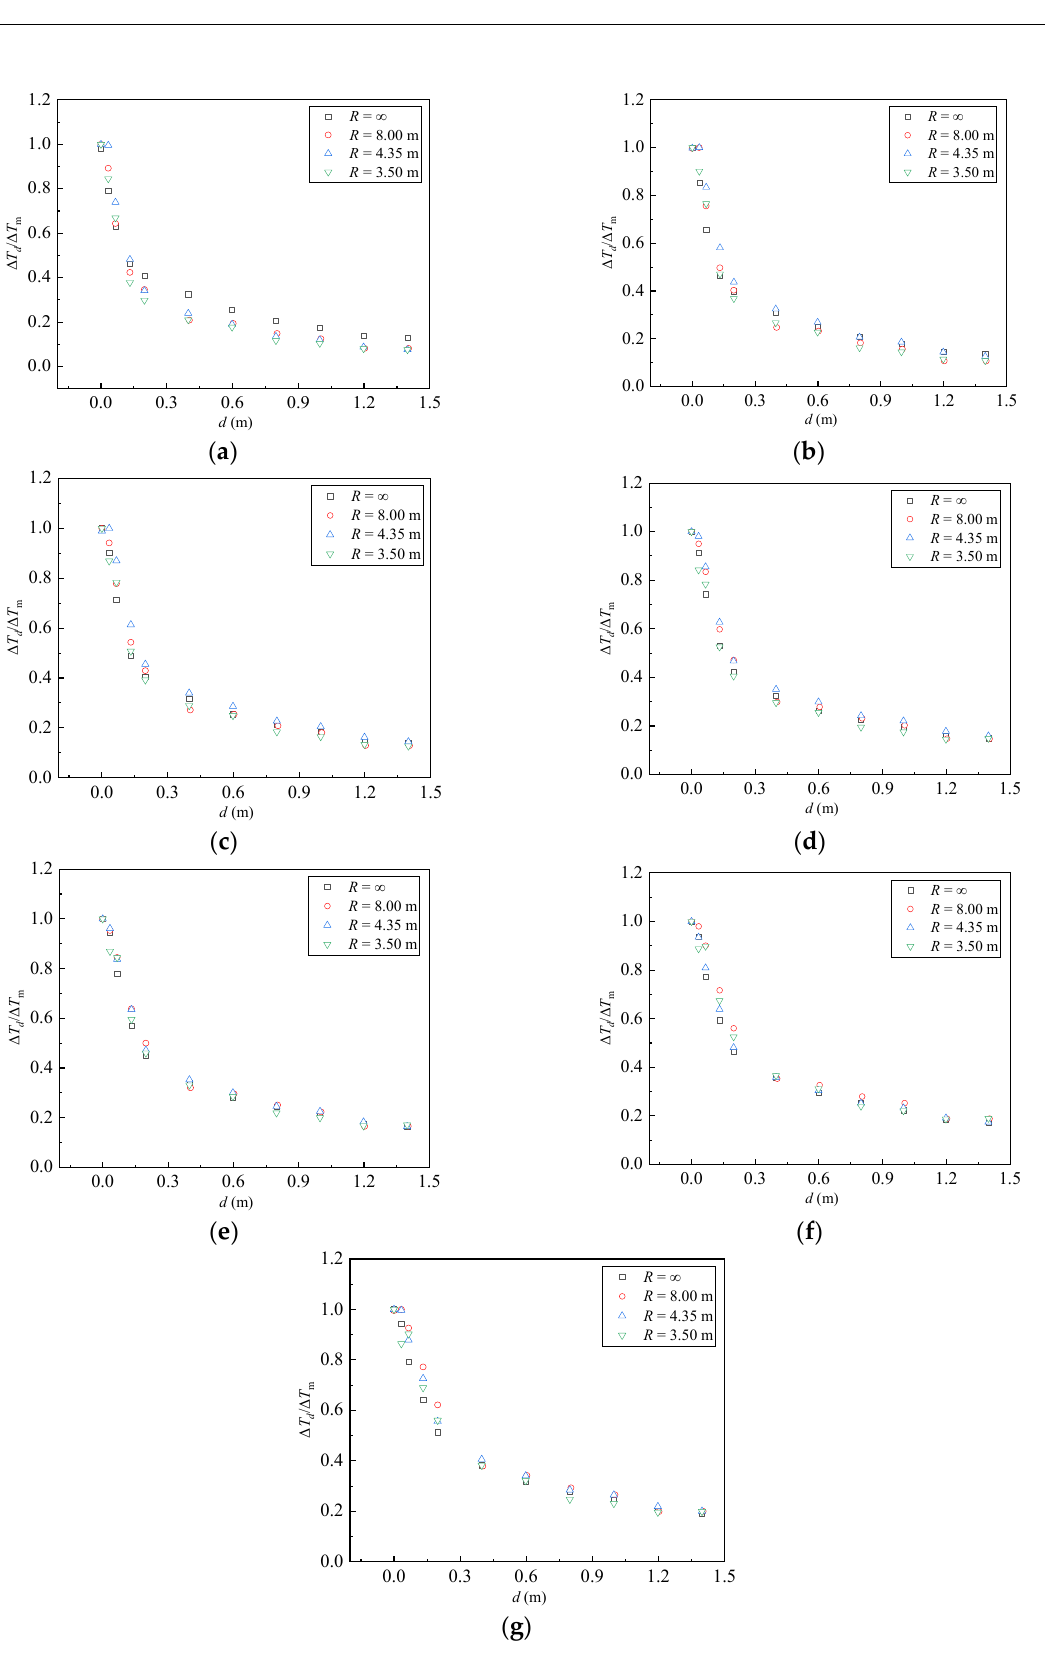
. . Q = 1.01 kW; ( c ) Q = 1.62 kW;